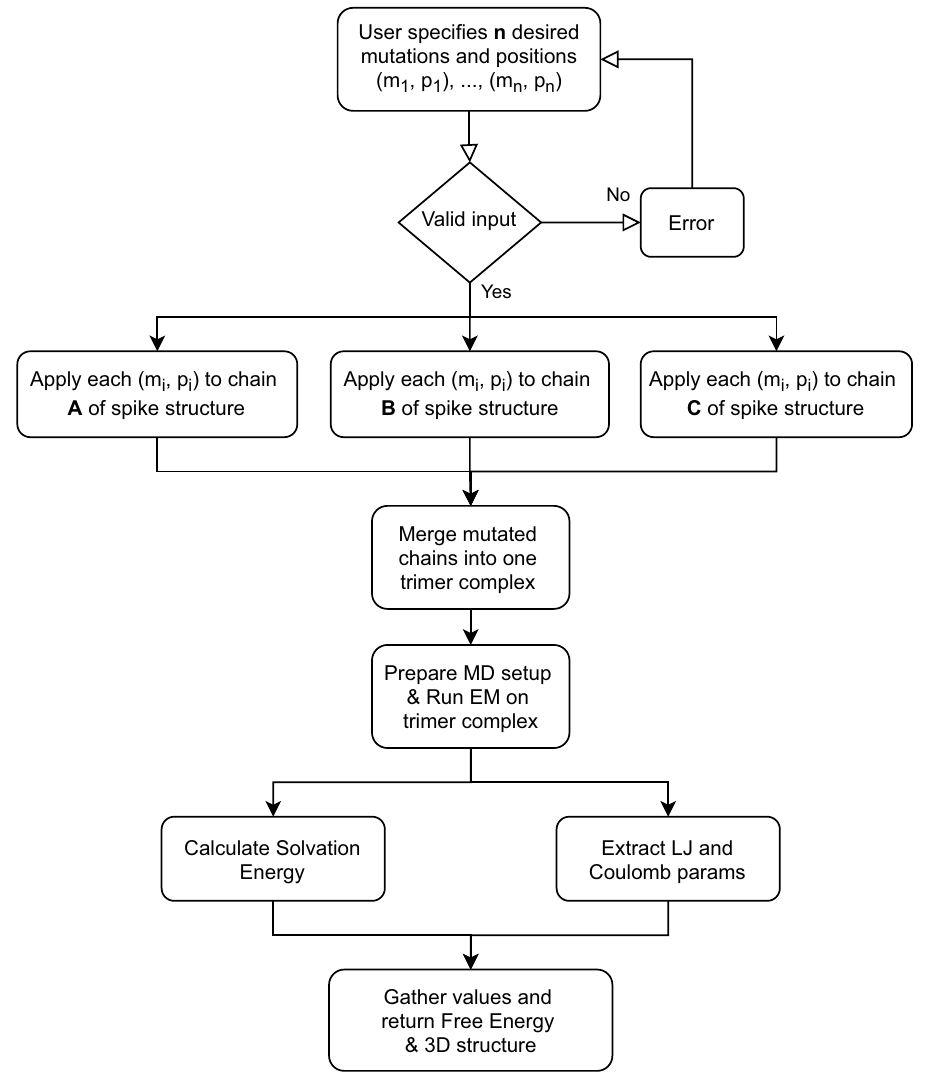
Figure 2. SpikeMutator pipeline. A flowchart describing the methods involved in mutating a SARS-CoV-2 spike protein. Mutations are applied to each trimer in the complex and a resulting atomic structure file is generated along with an output of the resulting free